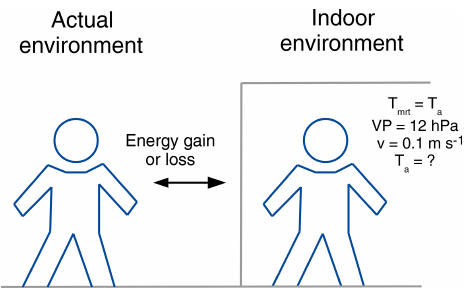
Figure 2. Schematic overview of the comparison of the energy gain or loss in the heat balance equation between the actual prevailing environment and a virtual indoor environment for the estimation of the physiologically equivalent temperature. The sample human is represented by the MEMI